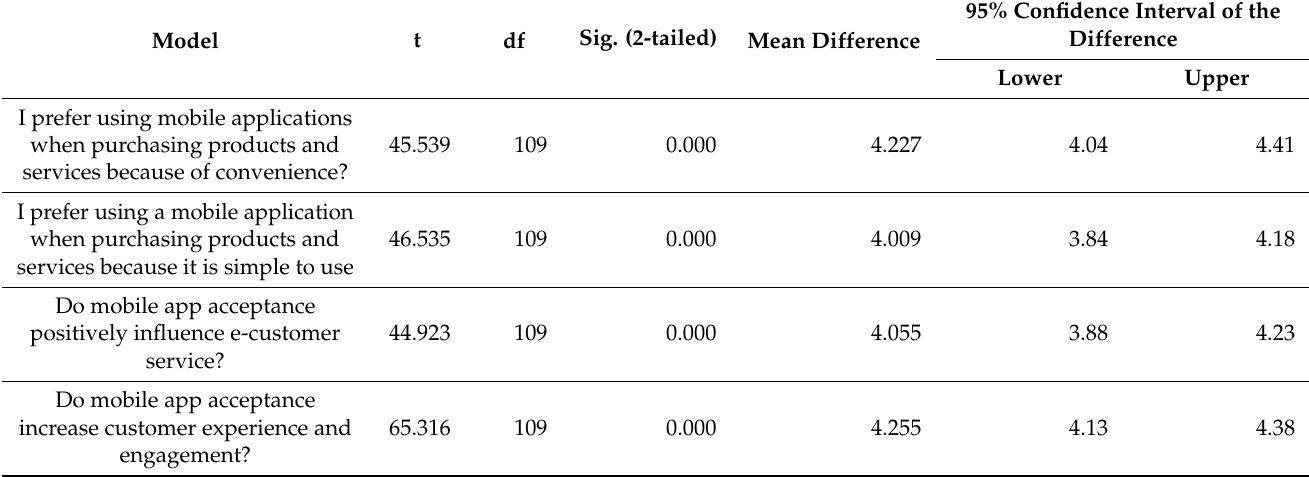
Table 2. One-Sample